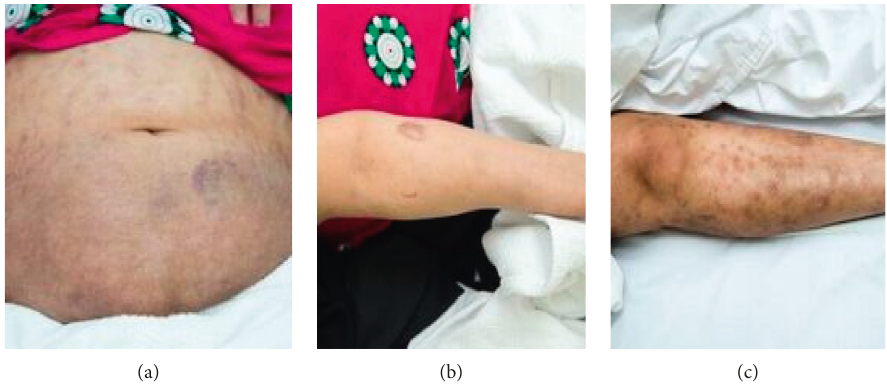
Figure 3: Residual hyperpigmentation without active psoriatic